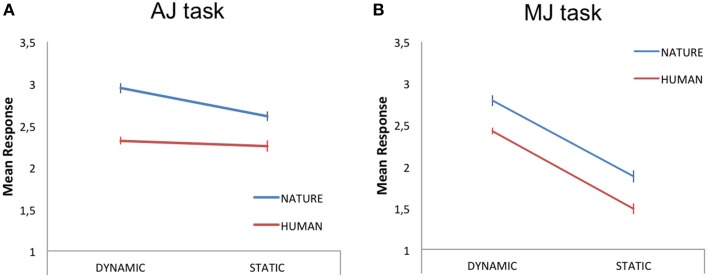
Mean judgment scores for the dynamic and static human (red line) and nature (blue line) content paintings during (A) aesthetic judgment—AJ—and (B) movement judgment—MJ—tasks. The bars represent the standard error of the mean.